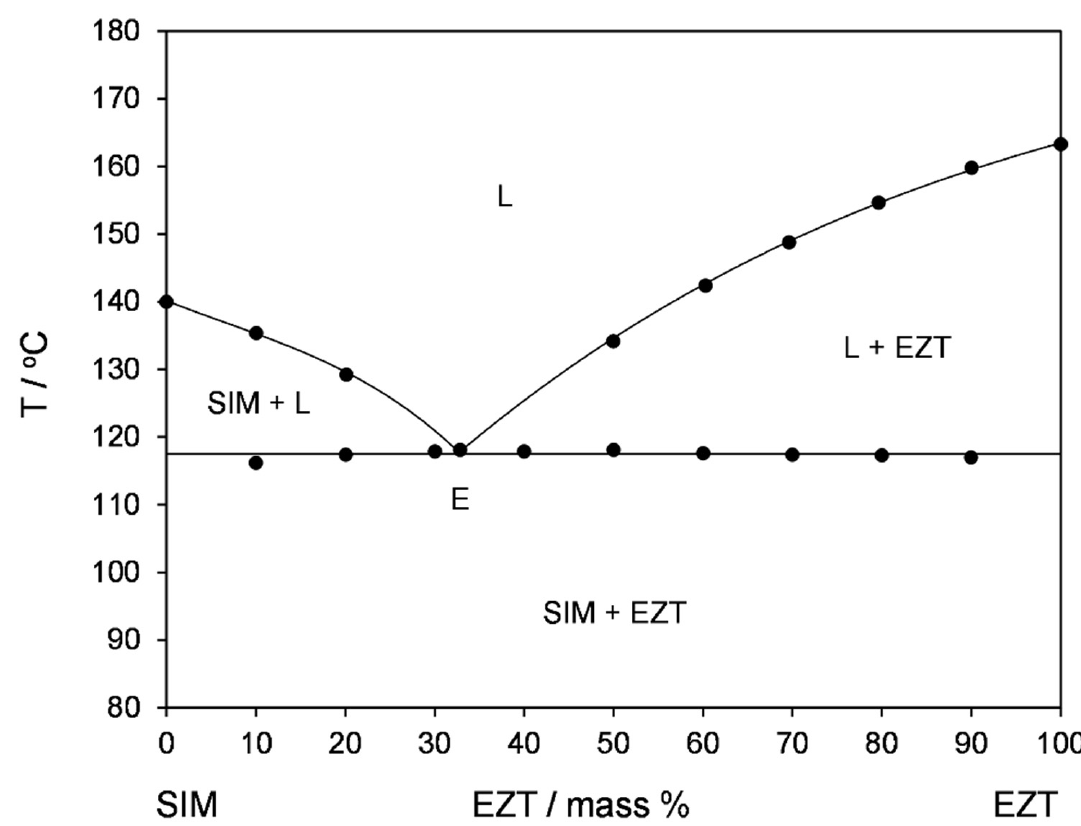
Figure 3. Tamman’s triangle of eutectic melting enthalpy, Δ H at 117.5 °C versus EZT mass %.